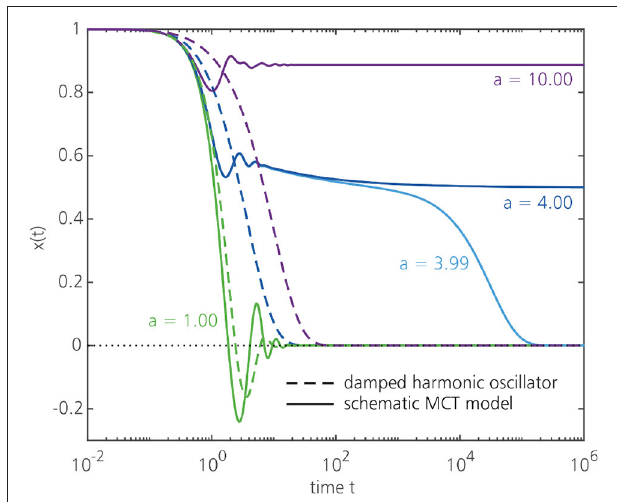
FIGURE 6 | Solutions x ( t ) for a damped harmonic oscillator, ¨ x ( t ) + ω 2 x ( t ) + a ˙ x ( t ) = 0 (dashed lines), and for a schematic MCT equation, t 2 ( t − s ) ˙ x ( s ) ds = 0 (solid lines), with ω 2 = 1 and a = 2 ζω . ¨ x ( t ) + ω 2 x ( t ) + a 0 x R Note the logarithmic scale for the time axis. As the damping a is increased, the MCT solution exhibits a highly non-linear slowdown and becomes non-ergodic for damping values a ≥ 4, signaling the formation of a glass. For the damped harmonic oscillator, the solutions for a = 3.99 and a = 4 are indistinguishable on the scale of this